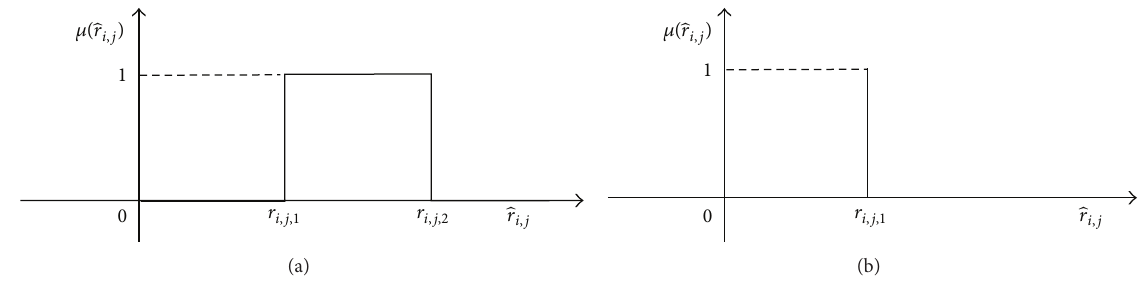
Figure 3: The concept diagram of interval (a) and crisp (b)